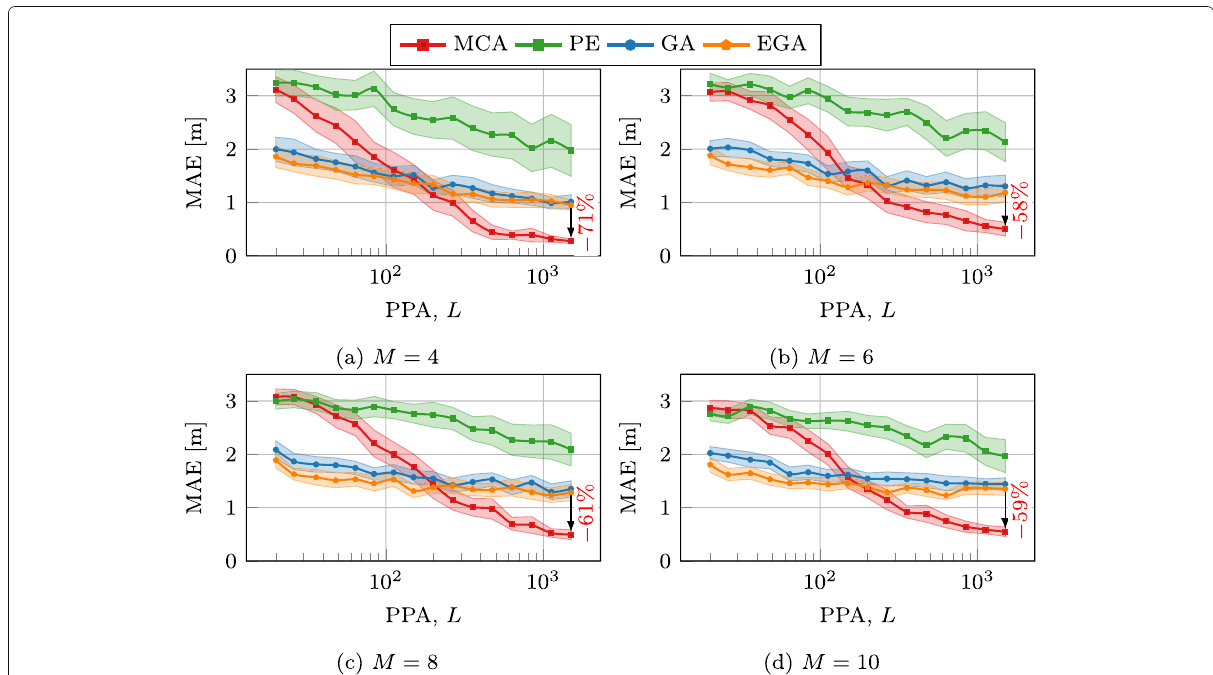
Fig. 10 Localization performance as a function of PPA for different numbers of agents: a four agents, b six agents, c eight agents, and d ten agents